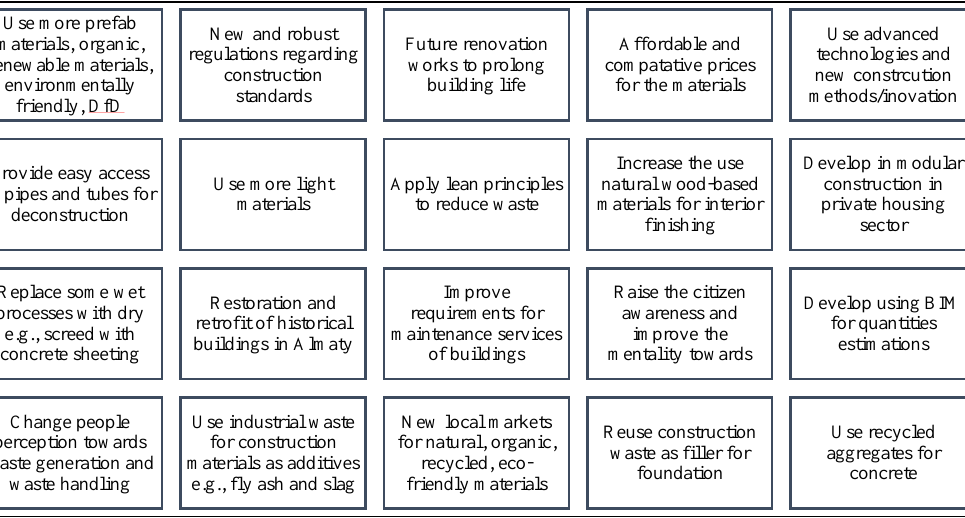
Figure 4. Project proposals from Kazakhstani construction sector stakeholders.